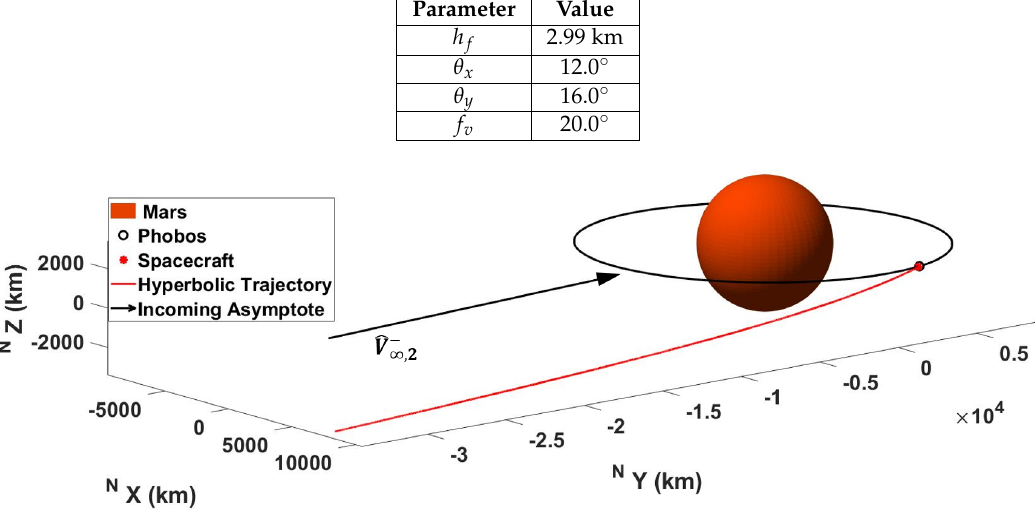
Figure 22. The designed hyperbolic trajectory of Perseus spacecraft during an encounter with Phobos. Encounter Performance